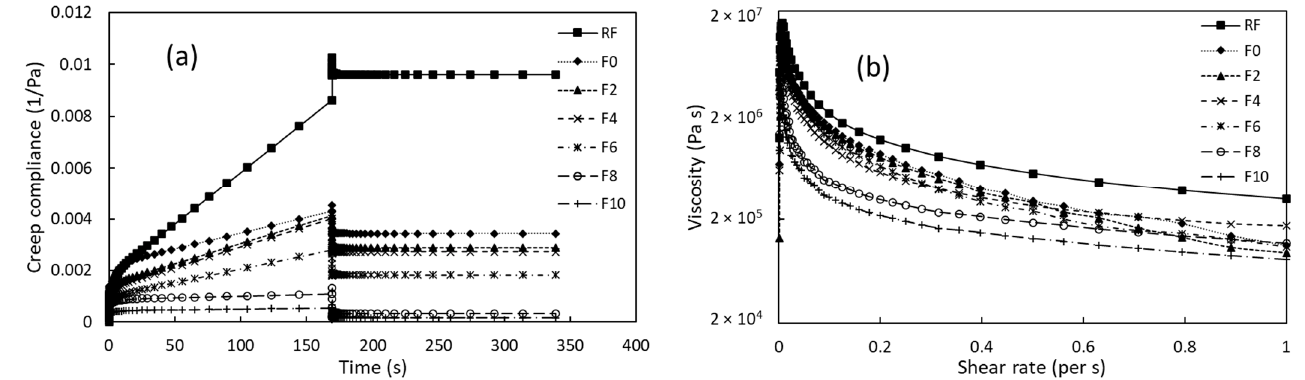
Figure 4. Rheological measurement of gels of RF, F0, and FRN samples: ( a ) creep recovery test and ( b ) steady shear analysis. RF represents rice flour, F0 represents 0% MLP, F2 represents 2% MLP, F4 represents 4% MLP, F6 represents 6% MLP, F8 represents 8% MLP, and F10 represents 10%